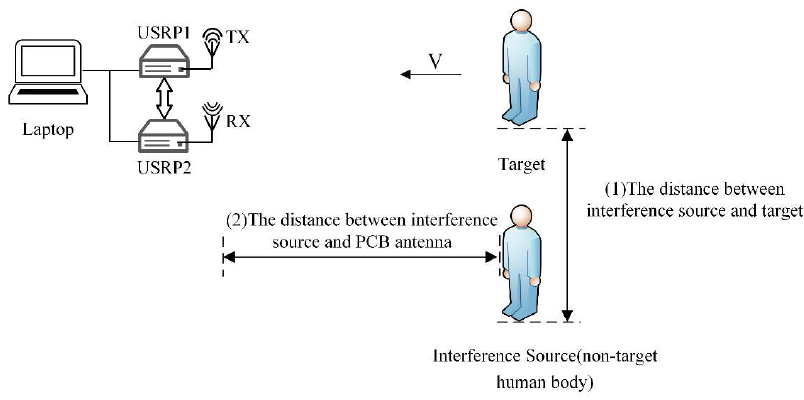
Figure 12. Illustration of two types of distances.